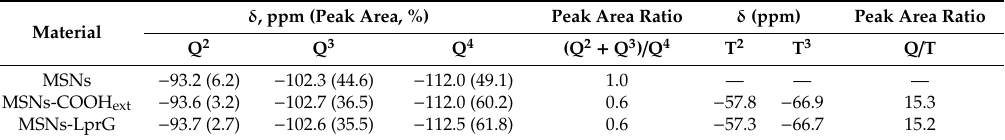
Figure 3. 29 Si cross polarization (CP) MAS NMR spectra ( A ) and 29 Si MAS NMR spectra ( B ) of MSNs, MSNs-COOH ext and MSNs-LprG materials. Table 3. Chemical shifts and populations (%) of the silicon Q n and T n environments and peak area relations, (Q 2 + Q 3 ) / Q 4 and Q n / T n units, on the basis of the deconvolution of 29 Si MAS NMR spectra of MSNs materials.